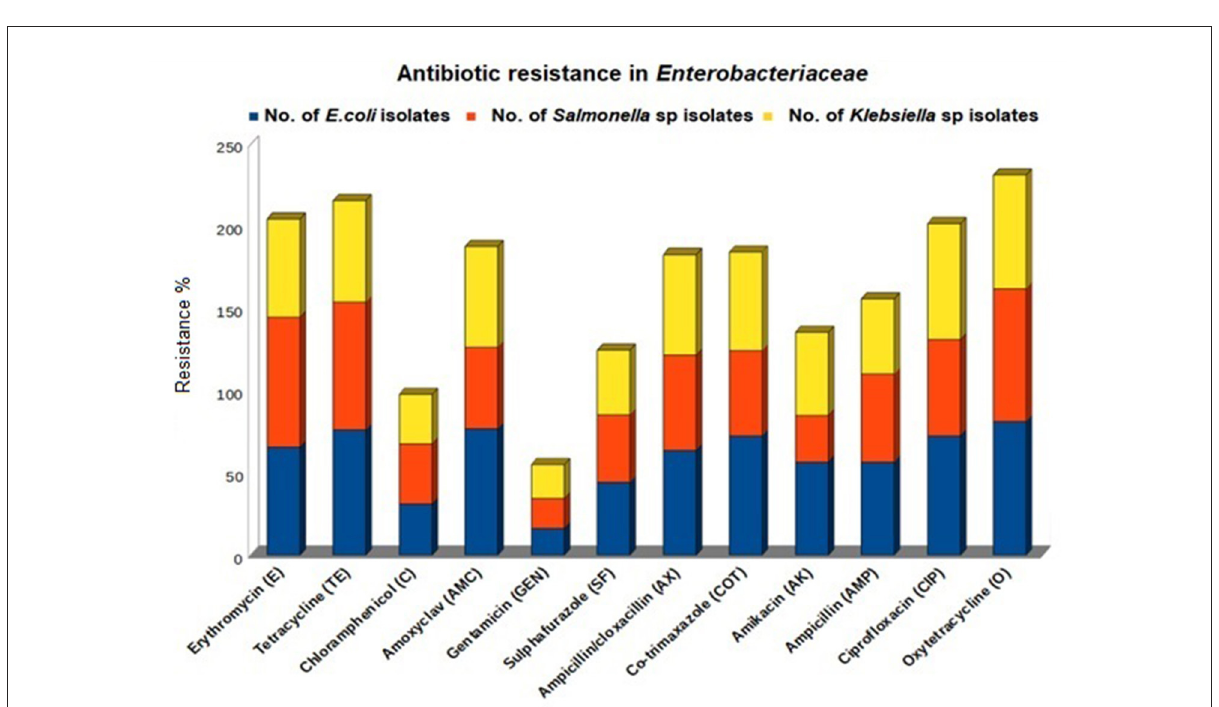
FIGURE1 Phenotypical antibiotic resistance profile of bacterial strains isolated from different birds reared in Andaman and Nicobar Islands (India).